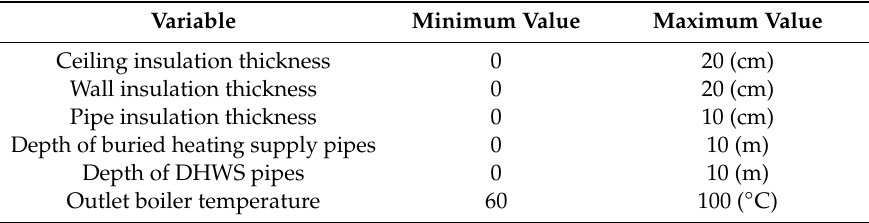
Table 8. Selected variables range of